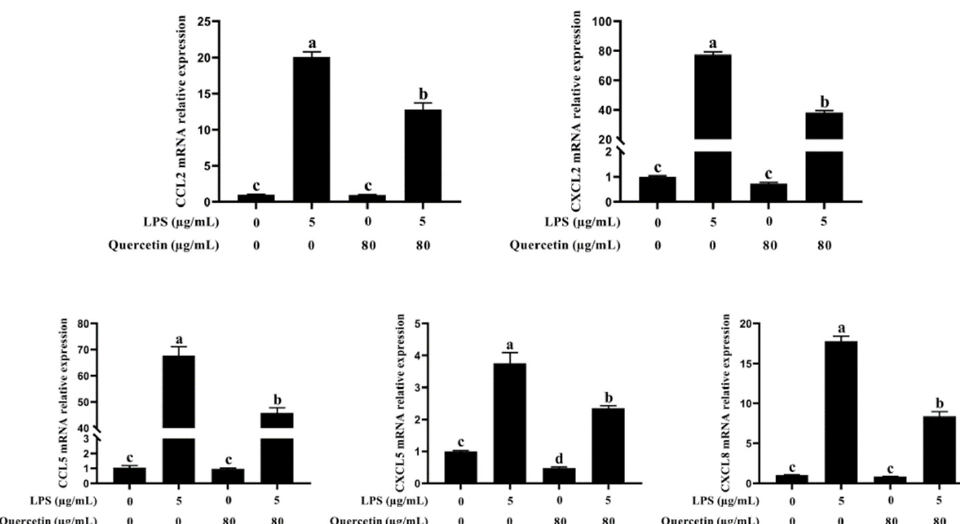
Figure 5. Quercetin’s effect on the mRNA expression of chemokines in LPS-stimulated BIECs. BIECs were treated with 80 µ g/mL quercetin in an environment of 5 µ g/mL LPS for 6 h. The mRNA expressions of CCL2, CCL5, CXCL2, CXCL5, and CXCL8 in BIECs were measured by qRT-PCR. The results are mean ± SEM (n = 6). Various lowercase letters in the line graph reveal significant changes ( p < 0.05).